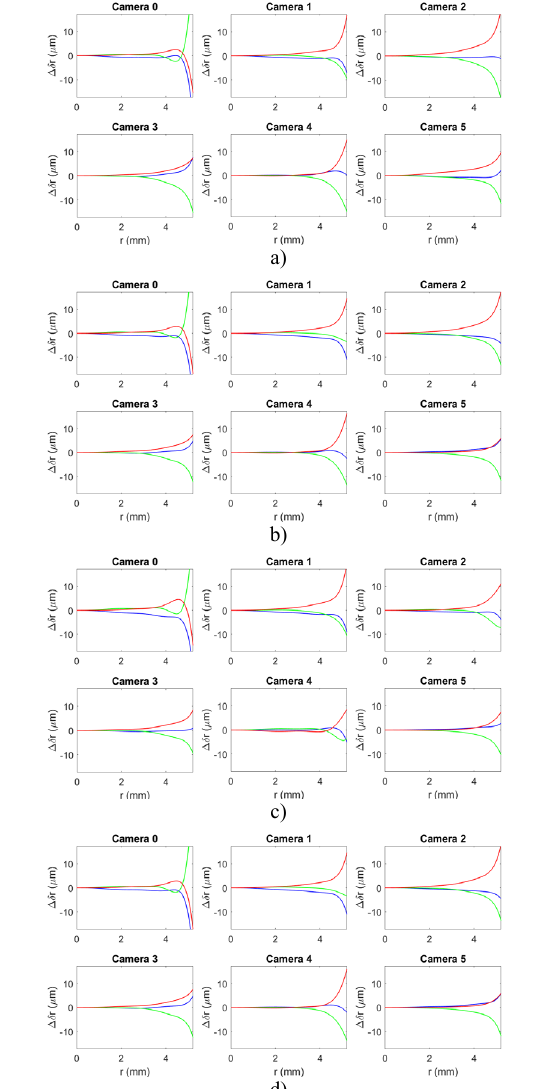
Figure 9. Ladybug5 radial lens distortion profile differences from the mean of all three bands for a) Case 1, b) Case 2, c) Case 3, d) Case 4.